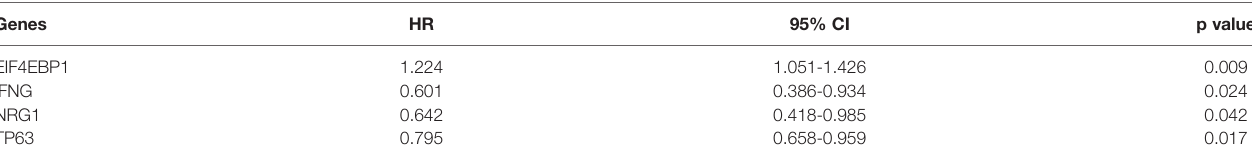
TABLE 1 | Univariate cox regression analysis identi fi ed 4 ARGs related to the BC risks.